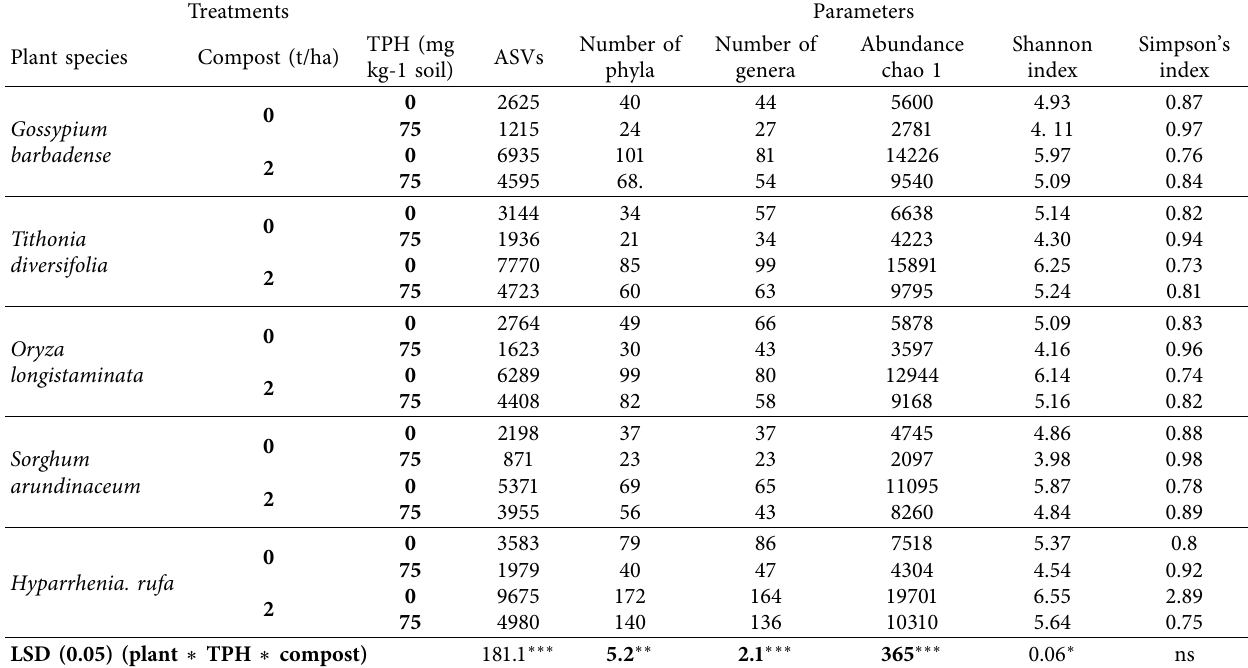
Table 2: Rhizobacteria community abundance and diversity in phytoremediation plant species biostimulated with cattle manure in hydrocarbon contaminated